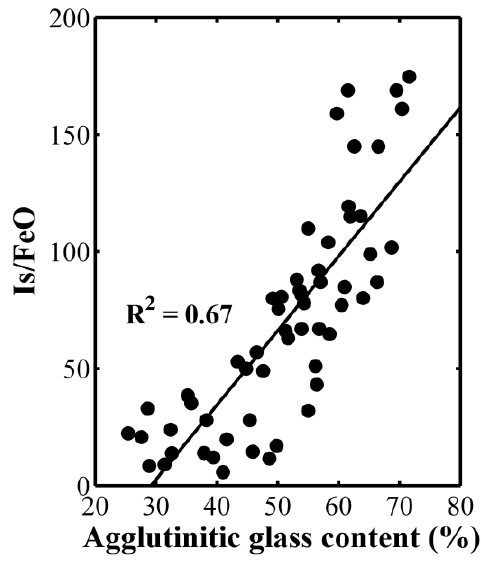
Figure 13. Correlation between the maturity (I s / FeO) and agglutinitic glass content of LSCC lunar soil samples. Solid black line is the linear regression